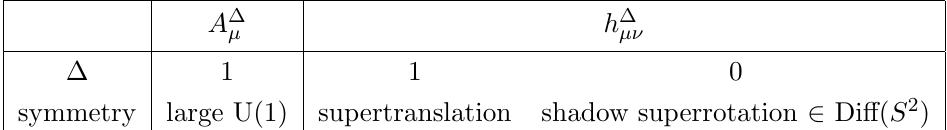
and e h e (cid:1)=2 (cid:0) (cid:1) are also pure gauge. While A (cid:1)=1 (cid:22) (cid:22)(cid:23) (cid:22) is the superrotation mode ~ h e (cid:1)=2 (cid:22)(cid:23) (cid:22)(cid:23)